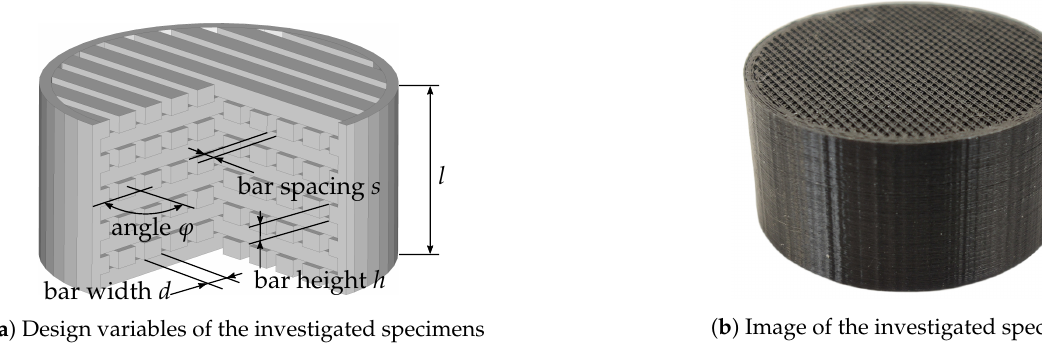
Figure 2. Overview of investigated specimen. ( a ) shows the test specimen including the design variables (from [26]) which are used to vary the test specimen. ( b ) shows the additive manufactured specimen 2.